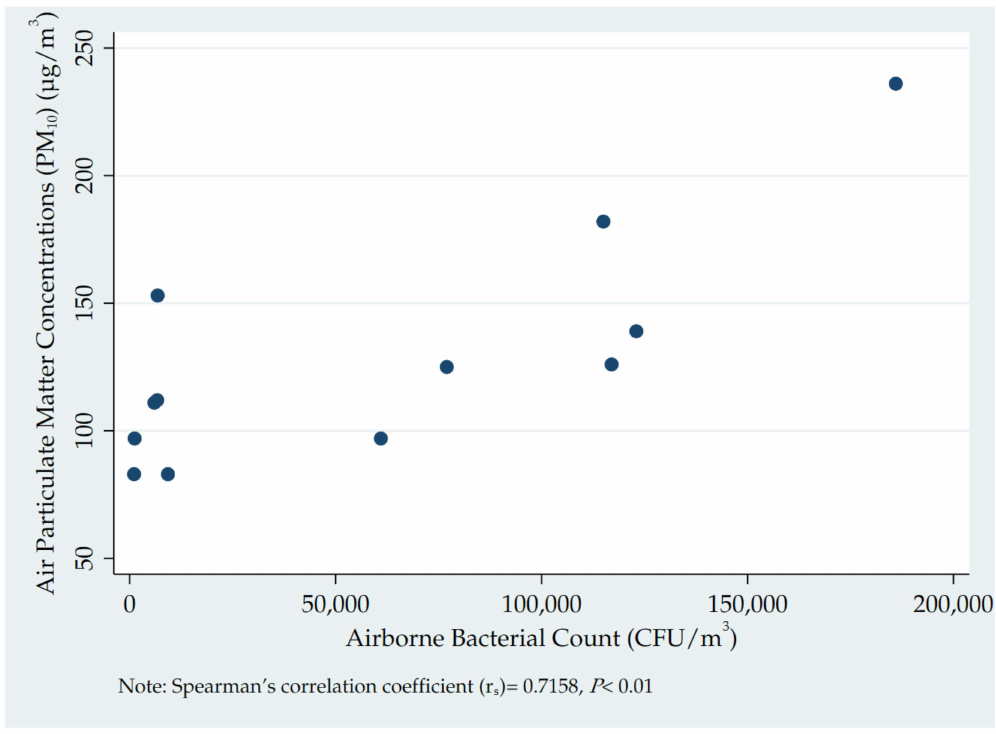
Figure 1. Association between airborne bacterial counts and PM 10 concentrations at the sites (roadside, industrial and residential) from which ambient air was sampled in Accra, Ghana, February